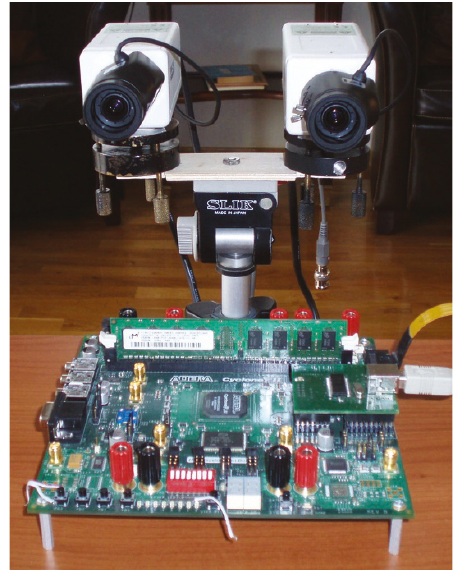
Figure 12: The stereo head with the FPGA